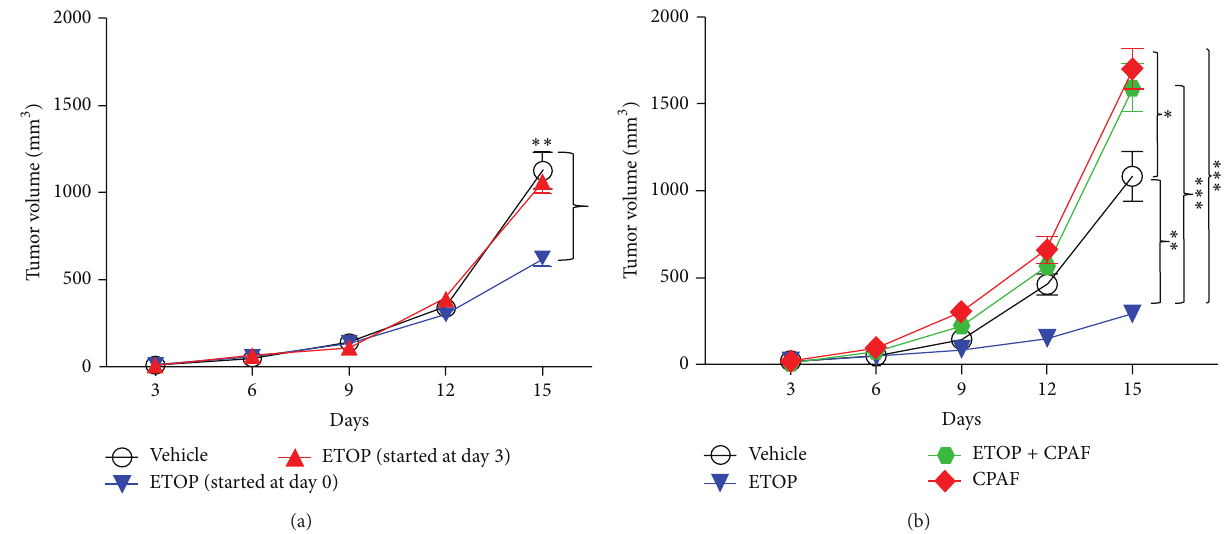
Figure 1: Modulation of B16F10 tumor growth by systemic chemotherapy with etoposide (ETOP) and the effect of PAF-R agonist (CPAF). (a) Murine B16F10 melanoma tumor cells (0.5 × 10 6 ) were implanted into the shaved dorsal hind flanks of syngeneic C57BL/6-WT mice (5–7 mice/group) subcutaneously (day 0). Mice were treated with or without ETOP (36mg/kg) intraperitoneally either at day 0, day 3, or day 6 repeated at every 3 days until the end of the experiment. Control mice received the vehicle (0.5% DMSO in 100 𝜇 L PBS) by the same route. Tumor growth was monitored and measured with digital caliper and tumor volume (major circumference × minor circumference 2 /2) was expressed as mean ± SEM per group. Statistical differences ( ∗∗ 𝑃 > 0.01 ) were noted between vehicle and ETOP treatment (day 0) at day 15. (b) Following subcutaneous B16F10 tumor cell implantation, C57BL/6-WT mice were treated with or without ETOP (36 mg/kg) intraperitoneally at day 0 repeated every 3 days until the end of the experiment. CPAF treatment (250 ng/mouse) was given intraperitoneally at days 0, 6, and 12. Control mice received the vehicle (0.5% DMSO in 100 𝜇 L PBS) by the same route. Tumor growth was measured and tumor volume (major circumference × minor circumference 2 /2) was expressed as mean ± SEM per group and compared between the groups. Statistical differences were noted between (1) ∗∗ 𝑃 < 0.01 , vehicle and ETOP groups; (2) ∗ 𝑃 < 0.05 , vehicle and CPAF groups; and (3) ∗∗∗ 𝑃 < 0.001 , ETOP and CPAF and ETOP and ETOP + CPAF groups at day